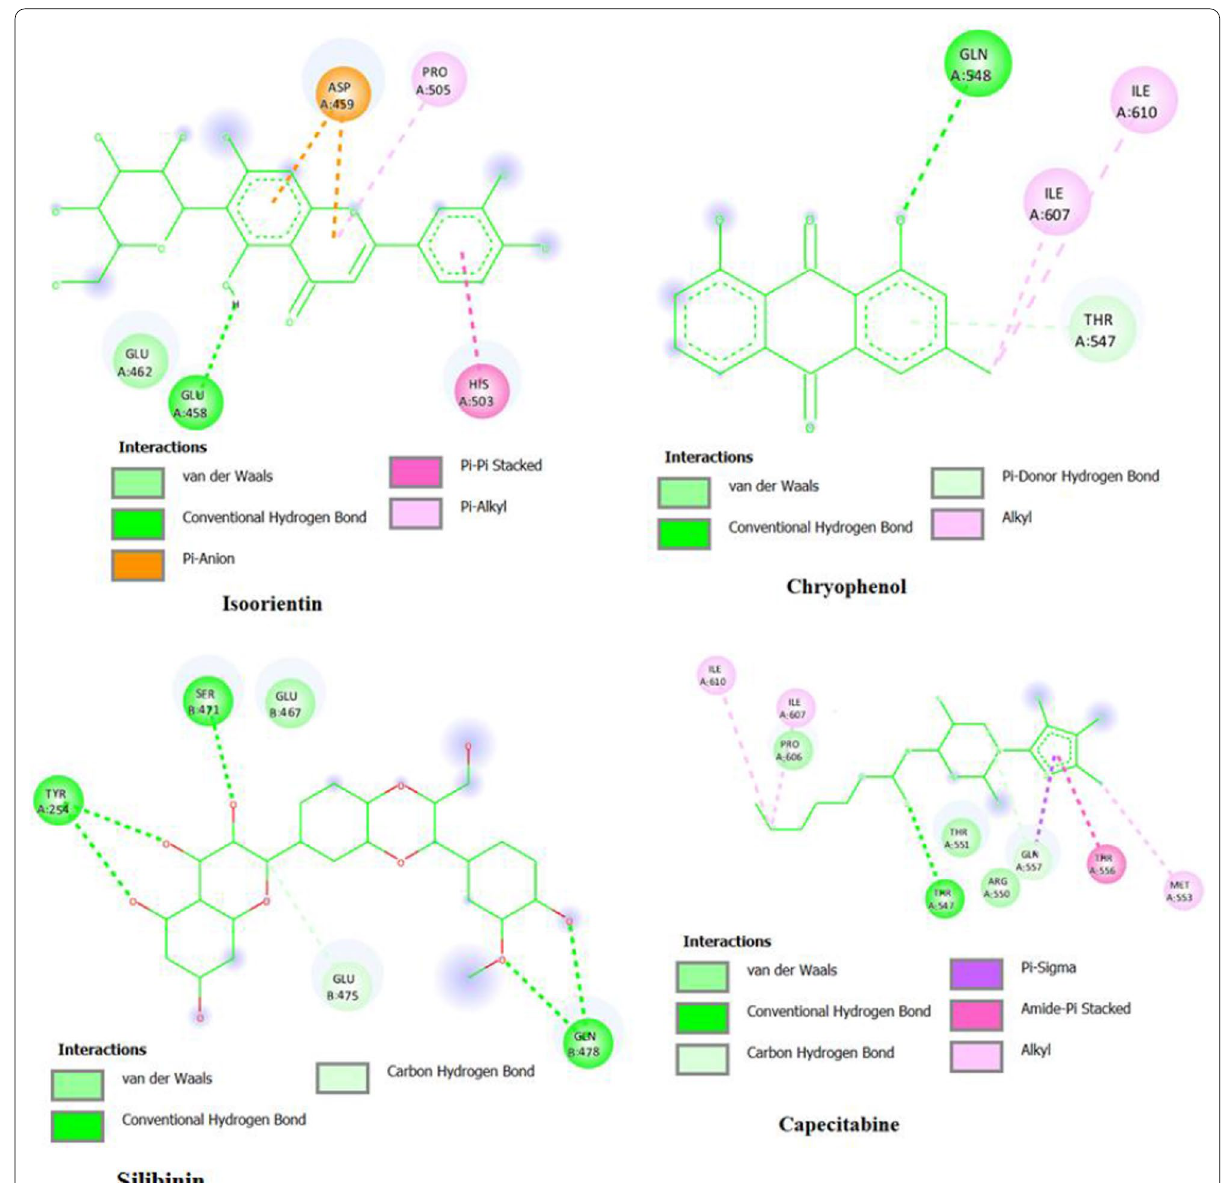
Fig. 4 Binding affinities of AXIN protein with phytochemical structure using AutoDock Vina. The 2D structure of protein–ligand interactions is visualized using a Discovery studio visualizer and the interactions are predicted based on binding energy (kcal/mol) and hydrogen